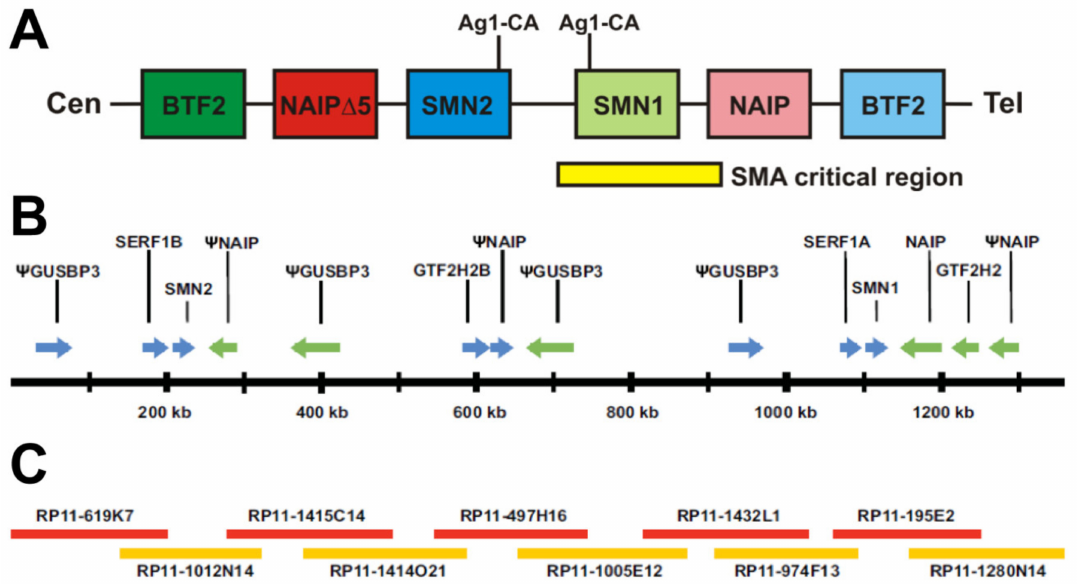
Figure 1. Genomic organization of SMN1 and SMN2 . ( A ) Original construction of the SMN region showing inverted duplication. The centromeric end of the chromosome is given on the left and telomeric end on the right. Ag1-CA markers are indicated above with lines to their approximate locations in SMN1 and SMN2 , thus suggesting inverted duplication. Further genes in the region, BTF2 and NAIP, are also given, further suggesting inverted duplication. ( B , C ) Map of the SMA region that was assembled using overlapping clones that originate from the same chromosome. ( B ) Map of the region showing all genes and their orientation. SMN1 and SMN2 are in the same orientation and are approximately 848 kb away from each other. Lying between SMN1 and SMN2 are 2 NAIP pseudogenes (one containing NAIP exons 6–17 and the other contained NAIP exons 3 and 6–9) and 2 GUSBP3 pseudogenes, as well as SERF1A and GTF2H2B . Pseudogenes are indicated with a ( Ψ ). ( C ) Overlapping clones used to construct the region. The smallest overlap between clones was 32,833 bp while the average overlap was 71,850 bp. There was only a single mismatched base pair out of all the overlapping